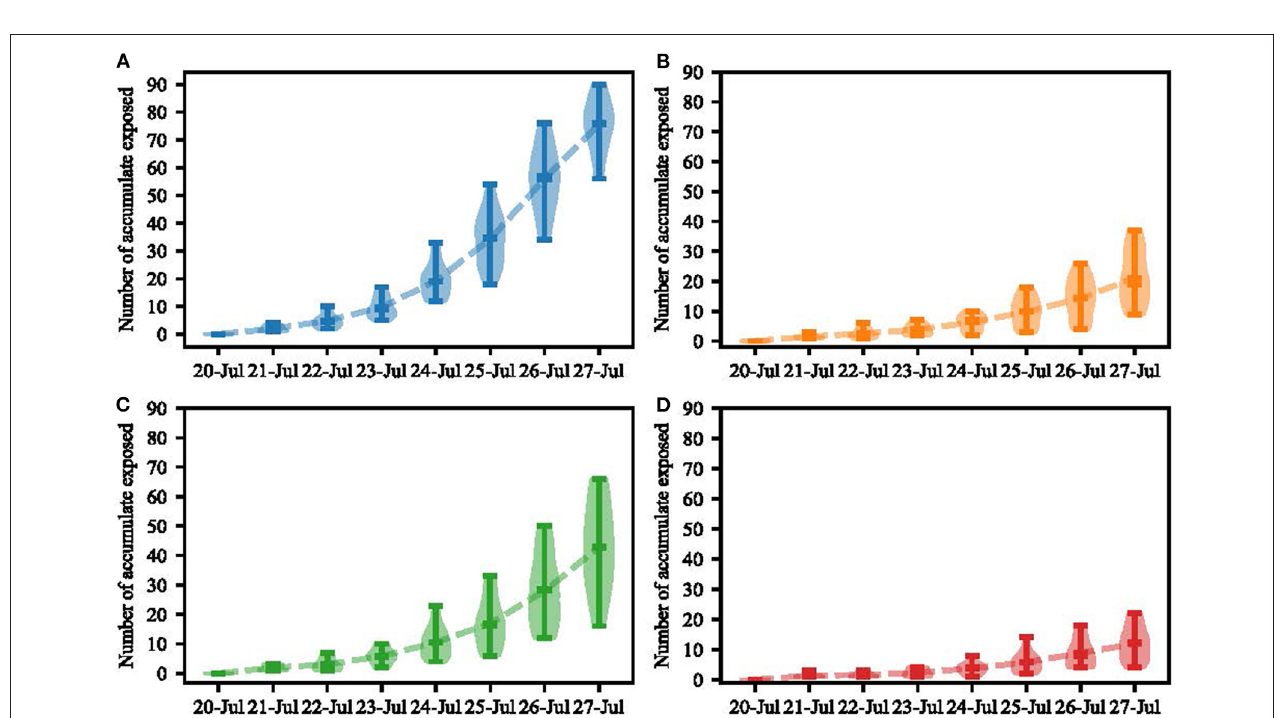
FIGURE 5 | Agent-based model simulation results (Yangzhou, China, 2021). (A) Simulation of virus transmission in a chess and card room over an 8-day period. (B) Simulation result of scenario 1. (C) Simulation result of scenario 2. (D) Simulation result of scenario 3.